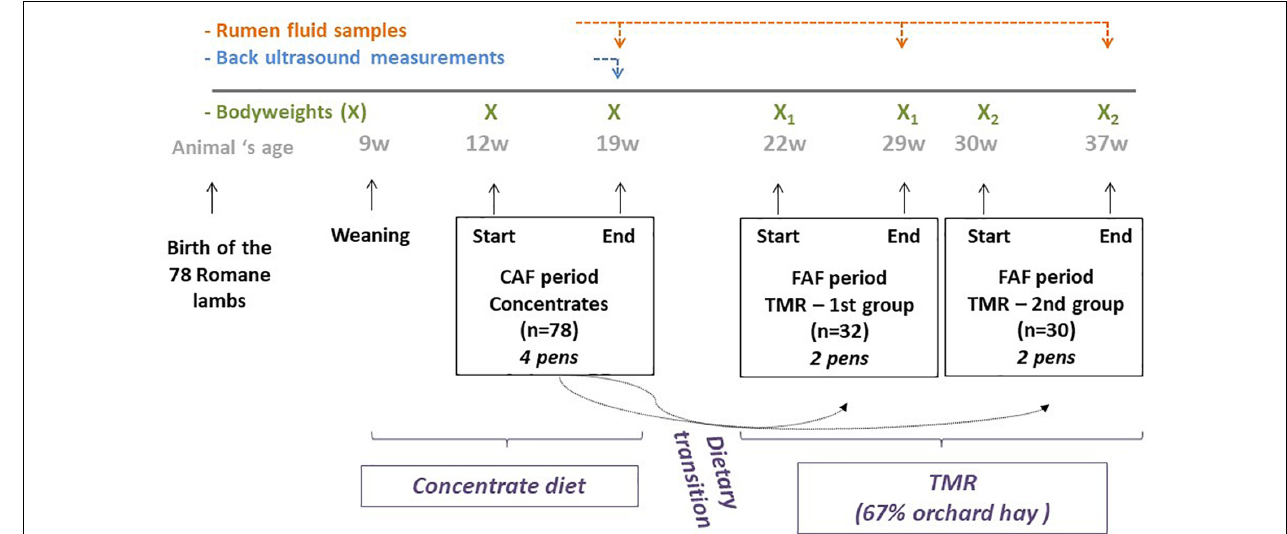
FIGURE 1 | Experimental design.